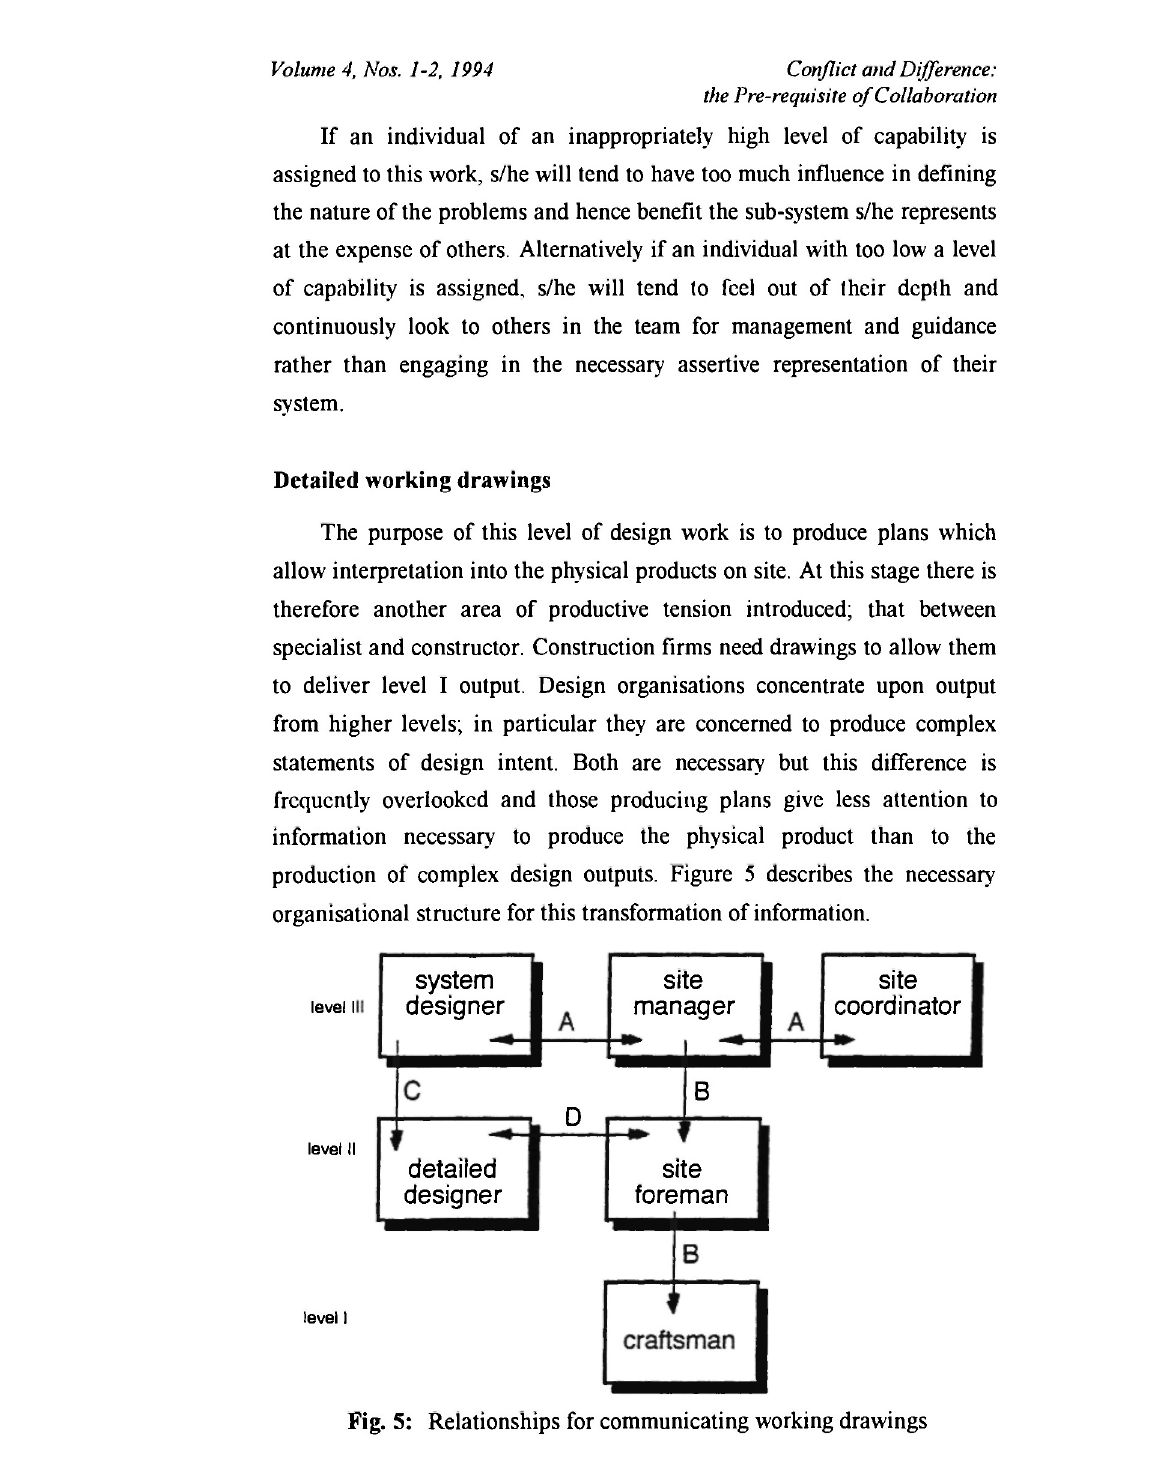
Fig. 5: Relationships for communicating working